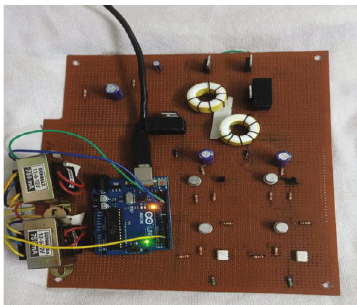
Figure 18: Hardware model of FKYBC with